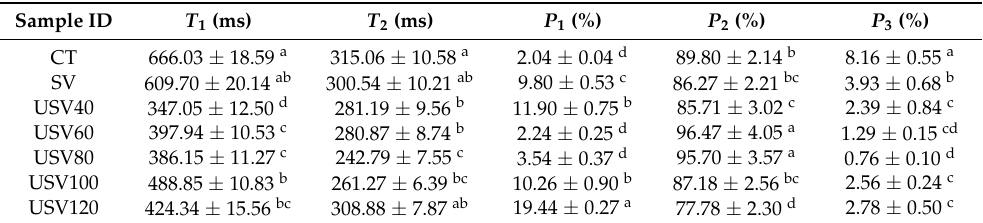
Figure 4. 2D T 1 - T 2 relaxation profiles of spiced beef under different thermal treatments. Table 2. Effect of different thermal treatments on LF-NMR relaxation time and peak areas of water forms in spiced beef.